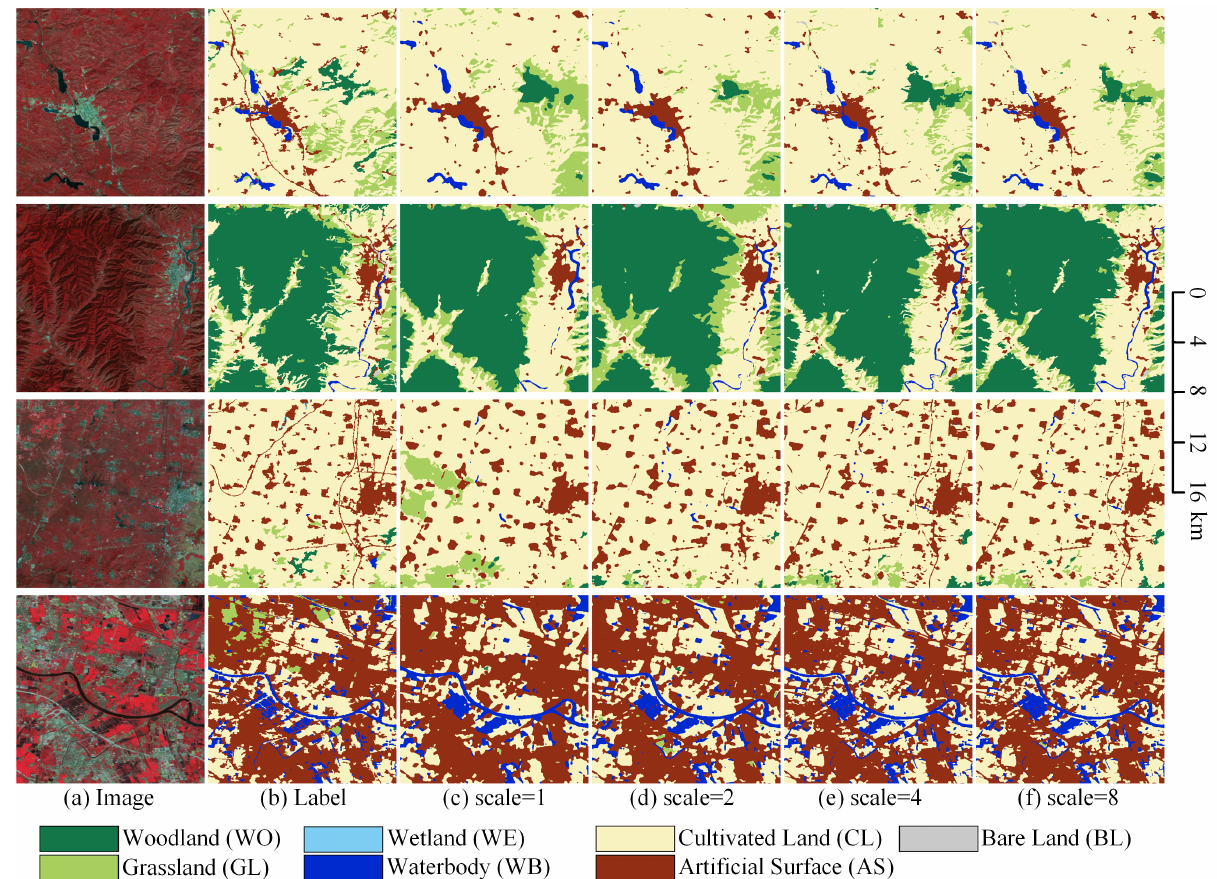
Figure 19. The visualized comparison of different upsample scale values on the Landsat core dataset. ( a ) Landsat image. ( b ) Ground truth. Inference result of ( c ) the BSNet with the upsample scale is 1, ( d ) the BSNet with the upsample scale is 2, ( e ) the BSNet with the upsample scale is 4, and ( f ) the BSNet with the upsample scale is